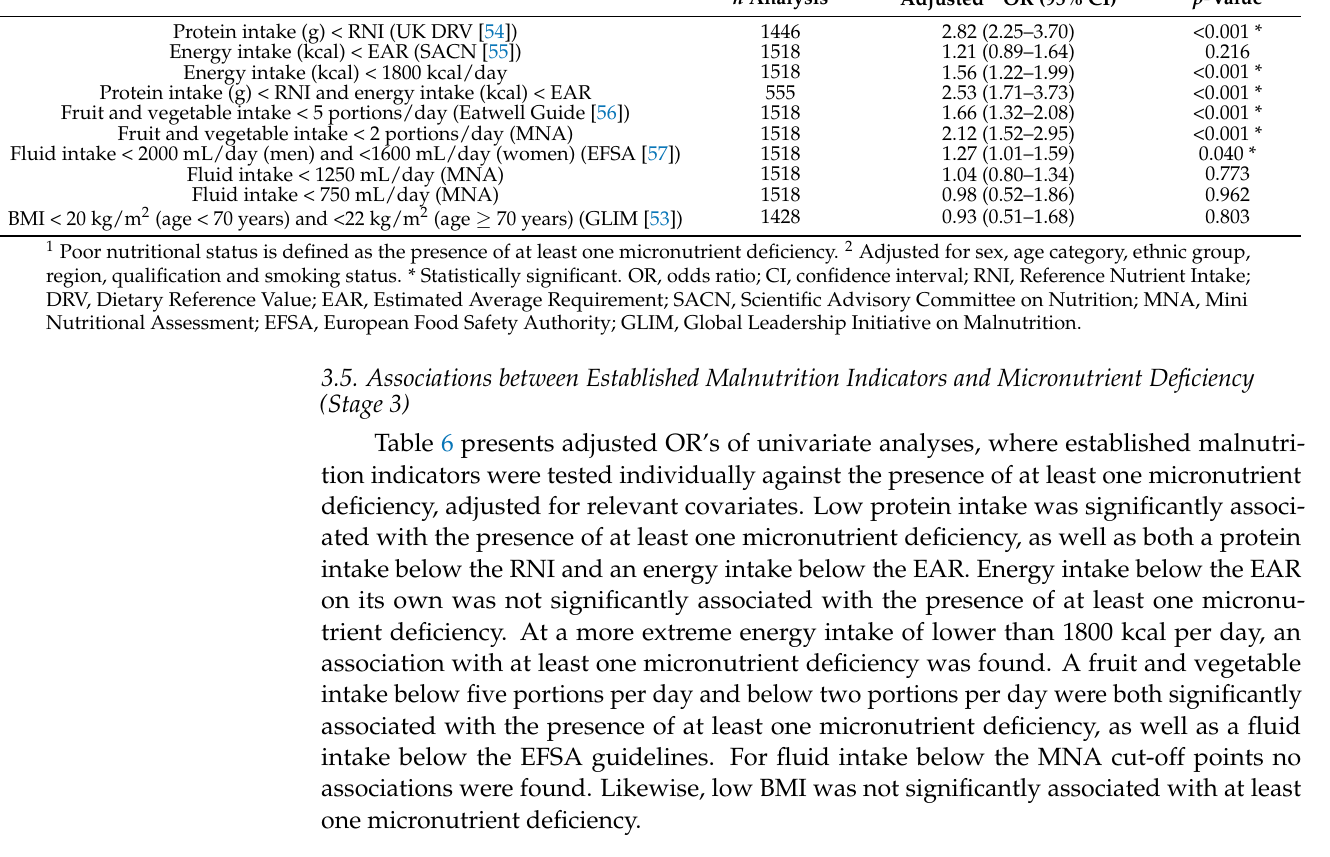
Table 6. Univariate logistic regression analyses of poor nutritional status 1 as dependent binary variable and established malnutrition indicators as independent binary variables, adjusted for covariates (Stage 3). Low Levels of Established Malnutrition Indicators (Source Cut-Off